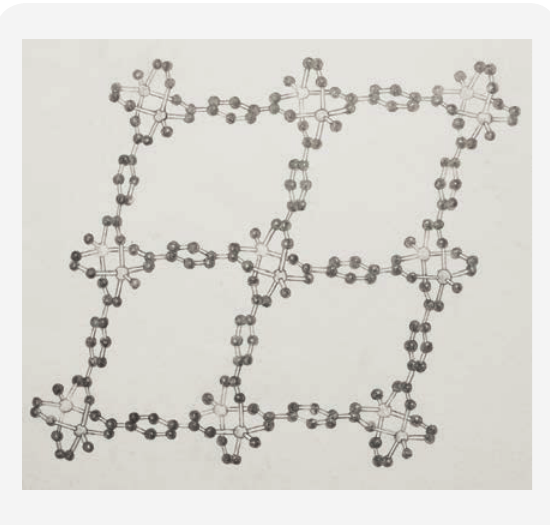
Fig. 1a. Crystal structure of metal-organic framework-2 (MOF-2), Zn(terephthalate). Zinc ions (light gray spheres) are linked by tere- phthalate into extended 2D porous structure. (Spheres terminal to zinc are oxygens from water ligands).